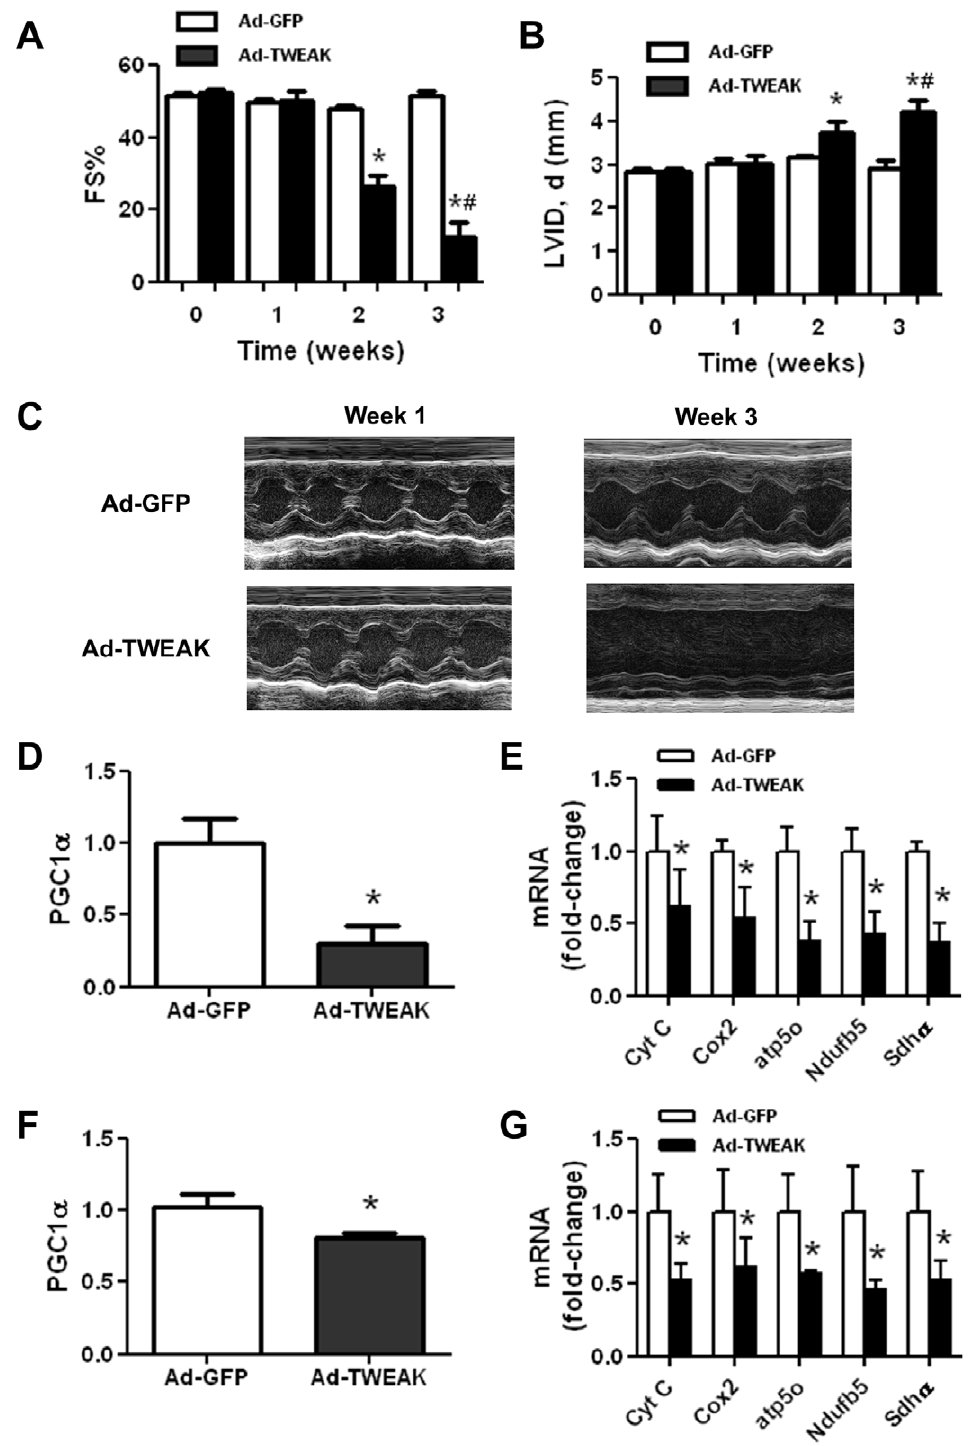
Figure 1. TWEAK induces cardiomyopathy and metabolic reprogramming in mouse hearts. (A) Fractional shortening (FS%, calculated as the difference in chamber dimension between diastole and systole over the chamber dimension in diastole) and (B) LV ventricular diastolic chamber dimension (LVID) were determined in mice by transthoracic echocardiography 1-day prior as well as 1, 2, and 3-week after intravenously delivery of control, Ad-GFP or Ad-TWEAK. (C) Representative M-Mode echocardiographic images at one week and three weeks post Ad-GFP and Ad-TWEAK injection in mice. Real time PCR analysis for expression of (D) PGCl a and (E) OXPHOS genes in cardiac samples at 3-weeks post-Ad-GFP or Ad-TWEAK injection. Real time PCR analysis for (F) PGCl a and (G) OXPHOS genes in cardiac samples at 1 week (prior to the development of heart failure) post-Ad- GFP or Ad-TWEAK injection. All real time PCR data were normalized to b -actin and presented relative to the Ad-GFP group. * p , 0.05 vs. Ad-GFP, # p , 0.05 vs. Ad-TWEAK-injected mice at 1 week time point, N=5 for each group.